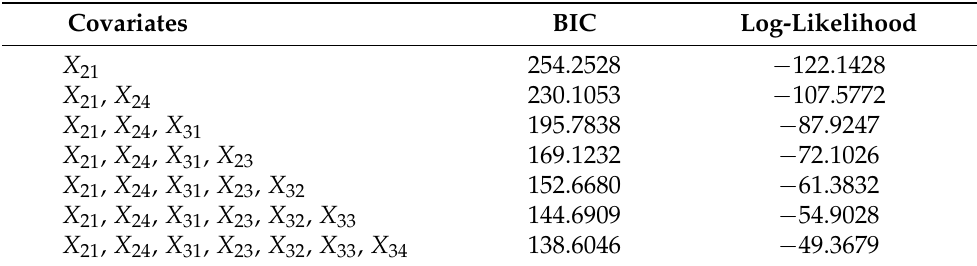
Figure 3. Scatterplot matrix for the listed covariates and response variables with Chilean PM data. Table 2. Results of the stepwise algorithm for the bivariate BS regression model and its corresponding BIC and log-likelihood values with Chilean PM